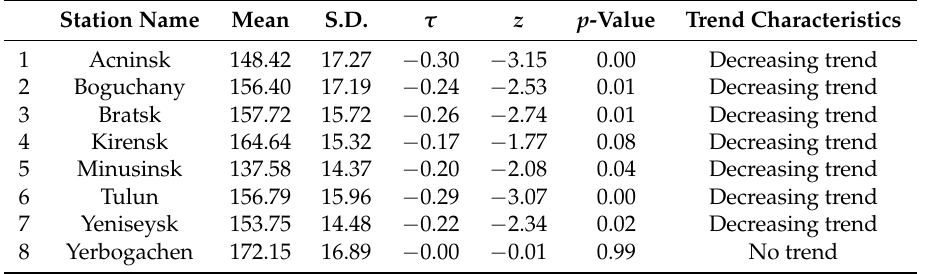
Table 3. Basic descriptive statistics for calculated logging season durations and the Mann–Kendall test